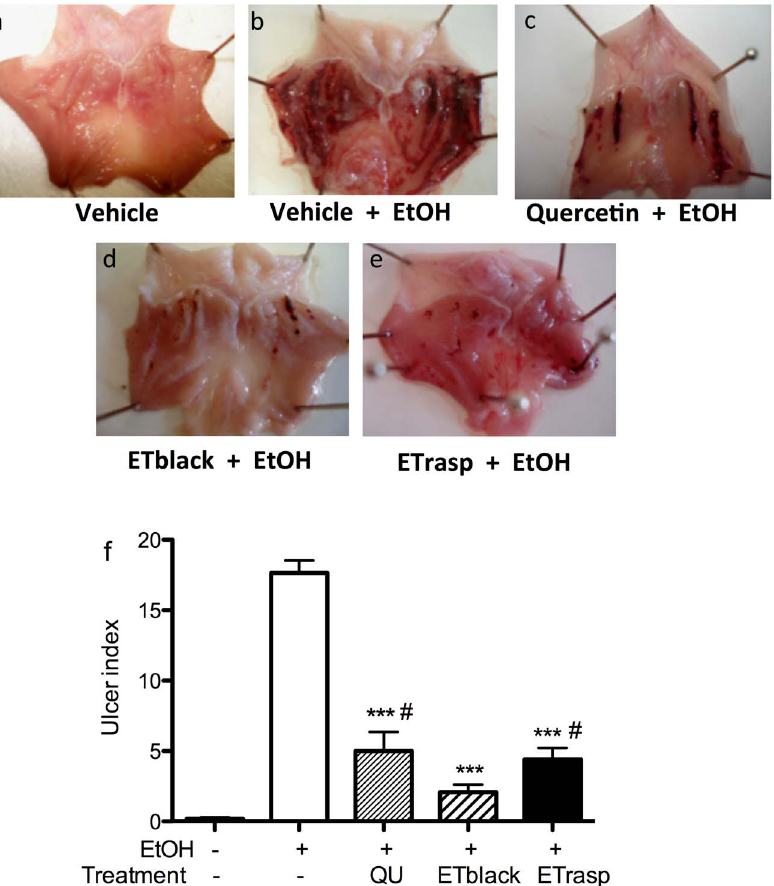
Figure 7. Protective effect of ETs from blackberry and raspberry against ethanol induced gastric injury. Wistar rats were randomly divided in 5 groups (6 rats in each group). Controls were treated daily with vehicle (10% polyethylene glycol 400; PEG 400) for 10 days. Ethanol group received the vehicle (10% PEG 400) daily for 10 days, and then 1 ml of ethanol. ETblack group received 20 mg/kg of blackberry ETs dissolved in 10% PEG 400 for 10 days, and then 1 ml of ethanol. ETrasp group recived 20 mg/kg of raspberry ETs dissolved in 10% PEG 400 for 10 days, and then 1 ml of ethanol. Quercetin group (positive control) received 100 mg/kg of quercetin dissolved in 10% PEG 400 for 10 days, and then 1 ml of ethanol. The last administration of ETs, quercetin or vehicle was given 120 min before ethanol. Treatment was performed intragastrically by gavage. Gastric damage was assessed in a blind manner by a scoring system based on the number and severity of the lesions: 0, no lesions; 1, lesions 1–2 mm; 2, lesions 2–3 mm; 3, lesions . 3 mm. Ulcer Index was calculated as the total number of lesions multiplied by their respective severity score. Results are the mean 6 se, n=6. ***p , 0.001.